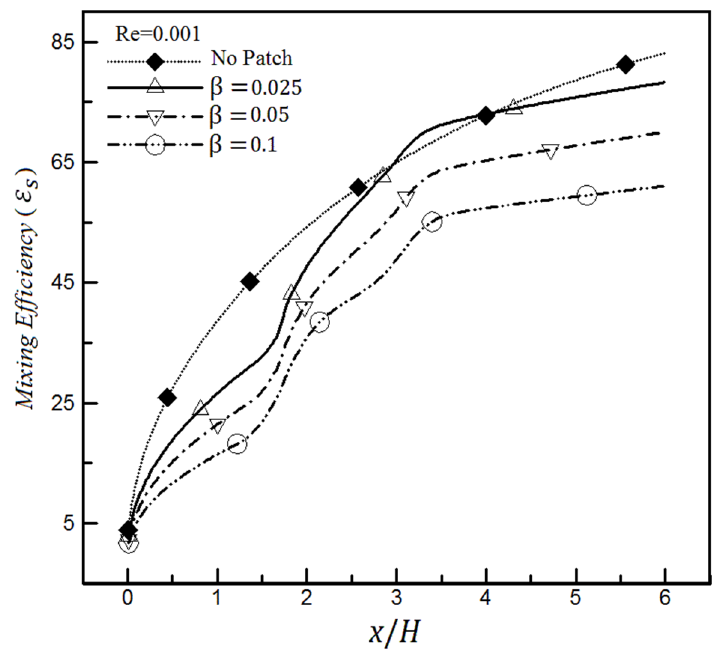
Figure 15. Mixing efficiency variations based on mixing entropy index in the non-homogeneous mi- crochannel for various slip coefficients, Re = 0.001, and a comparison with the homogeneous channel. It will be seen that such a situation will not continue as the Reynolds number